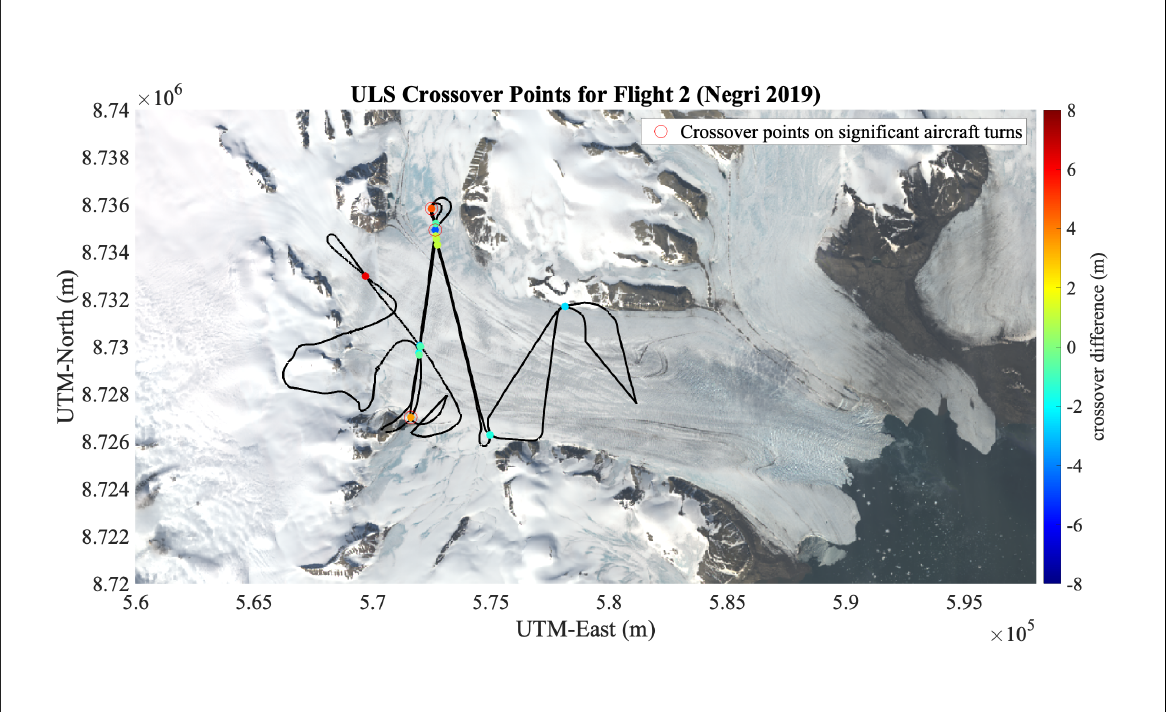
Figure 8. Crossover elevations from ULS data collection. Negribreen validation campaign. Flight 2, 13 August 2019. There are 14 crossover locations. Removing the three crossover points on large turns, for the remaining 11 points the mean difference is − 0.172 ± 2.564 m. Background: Landsat-8